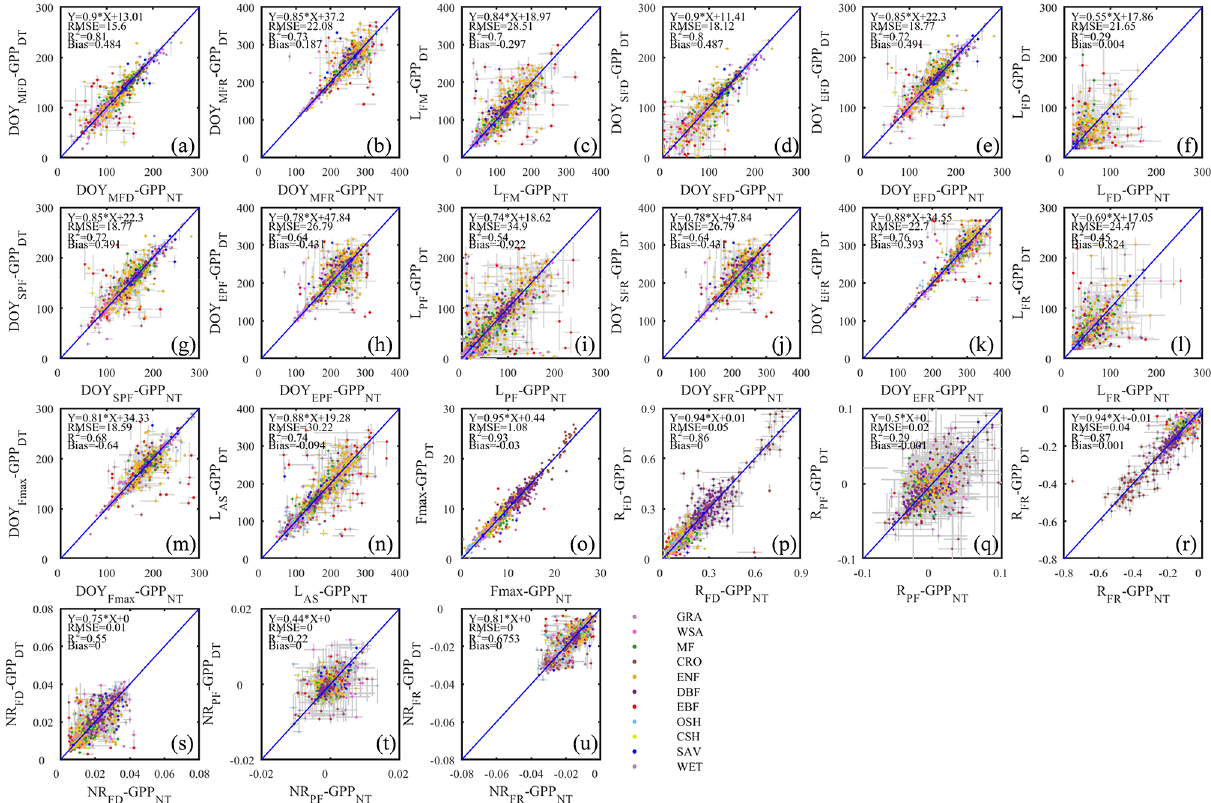
Figure 9. The scatter plots of different phenology metrics from GPP data using daytime and nighttime partitioning